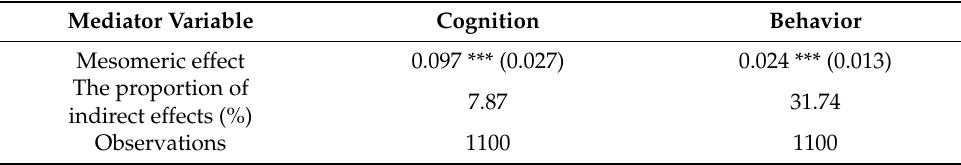
Table 6. Results of the mediation effect